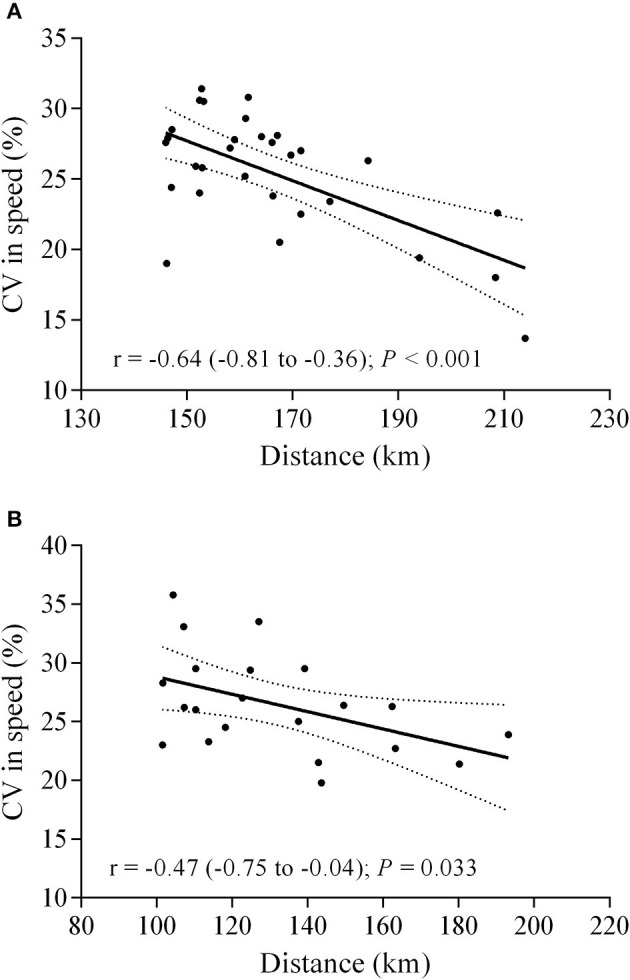
Correlation between speed coefficient of variation (CV) and total distance. (A) male (n = 30); (B) female (n = 21).